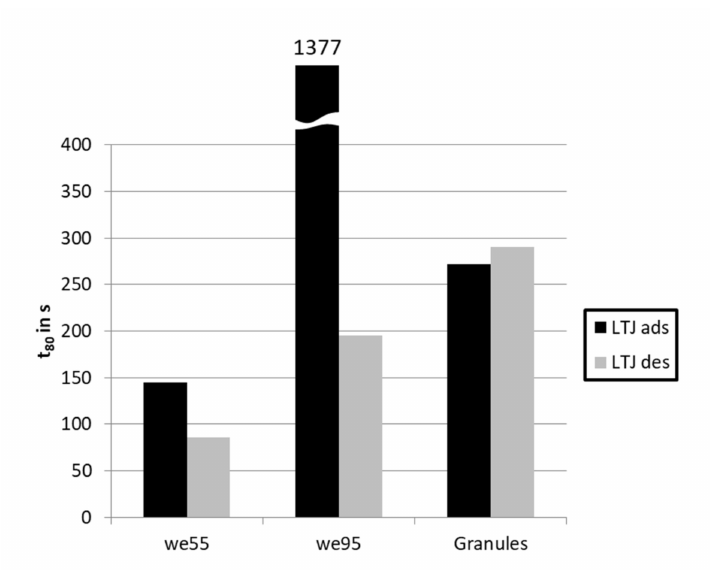
Figure 8. Dynamic figure t80 for LTJ measurements on all three samples.